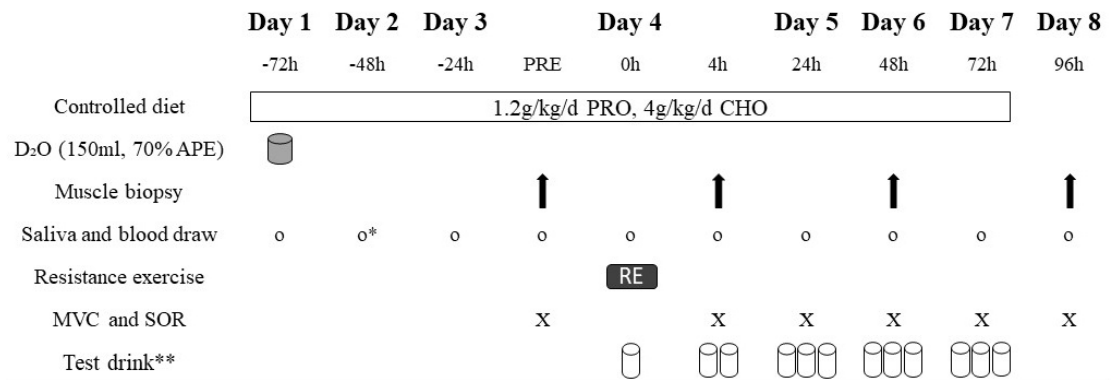
Figure 1. Overview of the 8 day exercise trial. PRE, pre-exercise; PRO, protein; CHO, carbohydrate; D 2 O, deuterium oxide; MVC, maximal voluntary contraction; SOR, perceived muscle soreness. * No blood draw was performed on Day 2. ** Test drink consisted of LEAAs or placebo. First test drink on